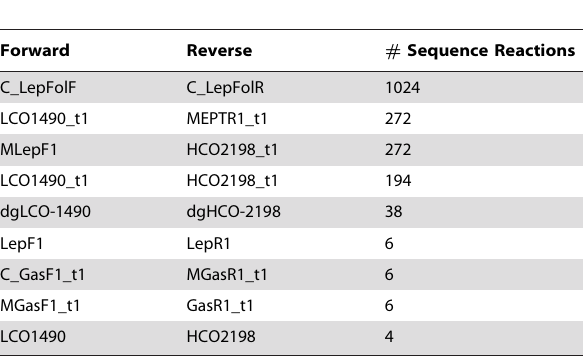
Table 4. Primer pairs used (forward + reverse) and number of sequence reactions each pair was